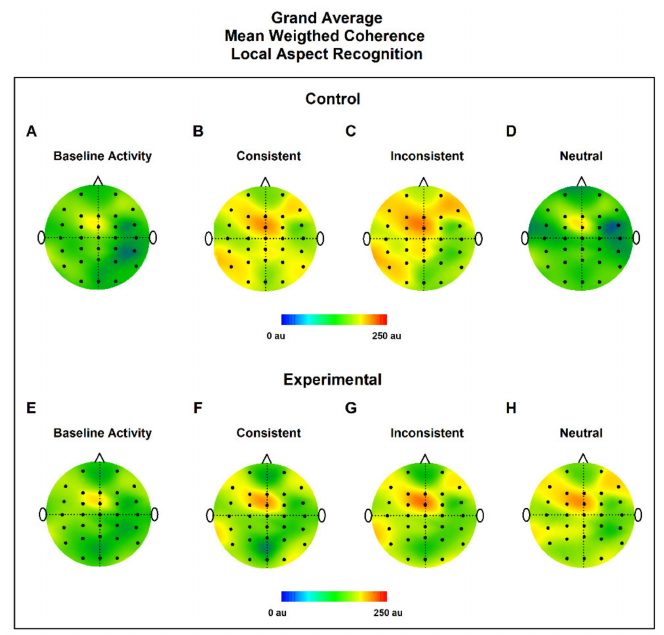
Figure 5. Grand average topographic maps of MWC for Local Aspect Recognition. Upper panel shows control group in EEG baseline activity ( A ), Consistent ( B ), Inconsistent ( C ) and Neutral conditions ( D ). Lower panel shows experimental group in EEG baseline activity ( E ), Consistent ( F ), Inconsistent ( G ) and neutral conditions ( H ). In all cases the maximum value of the MWC was found near FCZ located in the frontal